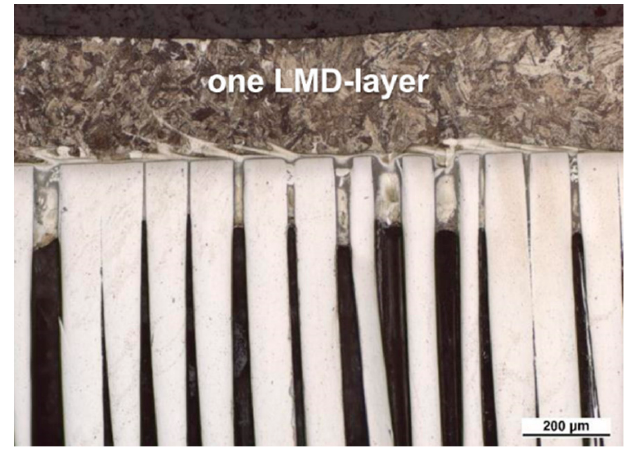
Figure 4. Light microscope image of a cross section of W-steel µ-brush prepared by LMD.